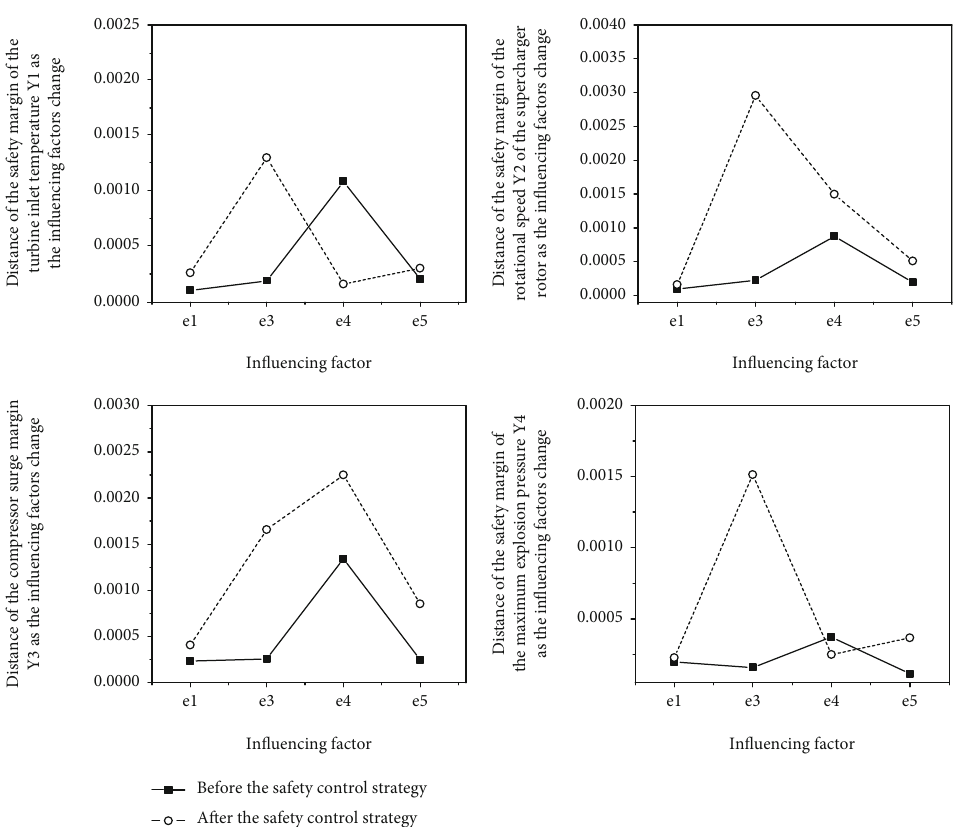
Figure 16: Comparison of the changes in the distance between the relative positions of each column point before and after using the safety control strategy.